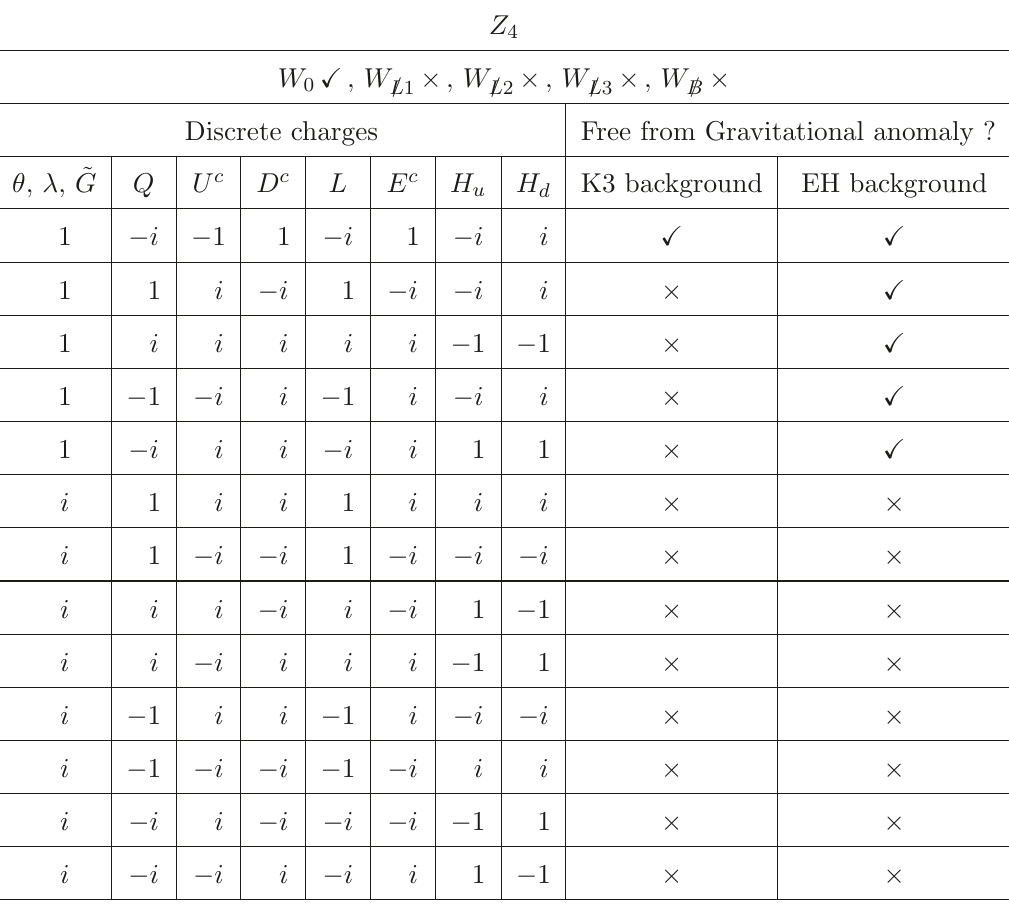
Table 6 . See the caption of table 2 for notations, and refer to the text in section 4.1.3 for more